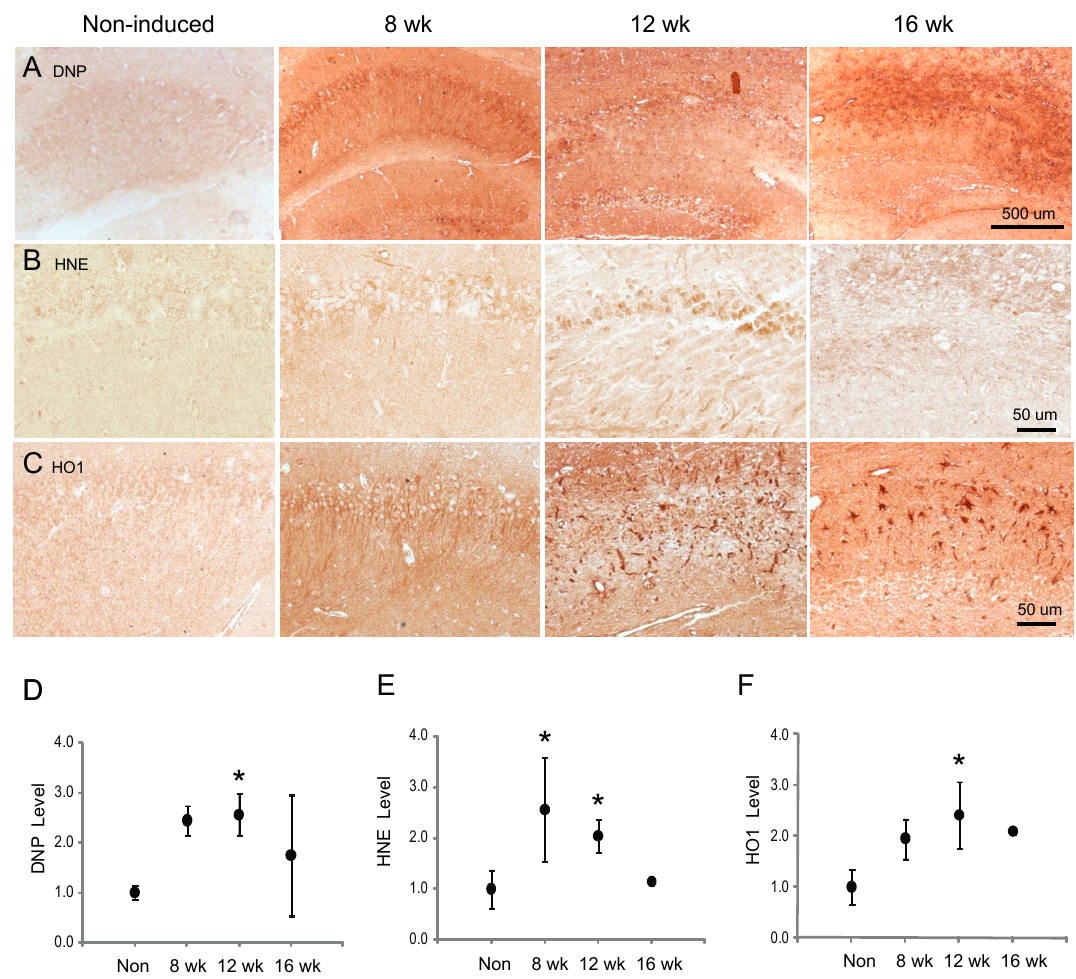
Figure 6. Increased oxidative damage and response is an early feature in this model. As early as 8 weeks post-induction, increased protein oxidation is seen in hippocampal neurons by utilizing the dinitrophenol (DNP) assay for protein carbonyl formation ( A , D ). Lipid peroxidation measured by immunohistochemistry for 4-hydroxy-2-nonenal (HNE) is also increased ( B , E ). There is a concomitant response of HO-1 induction in both the neurons and glial cells ( C , F ). * p < 0.05, ANOVA.